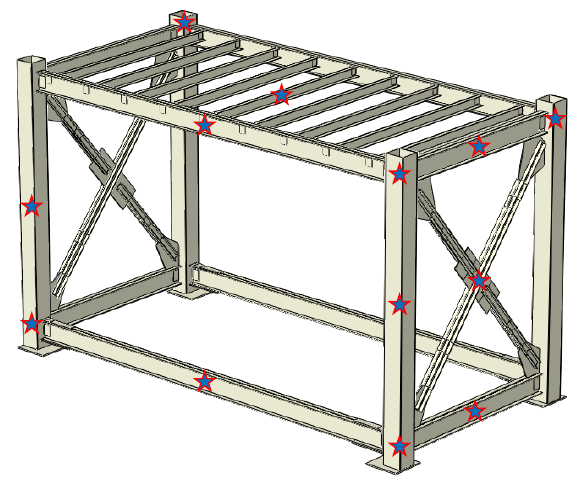
Figure 8. Locations of hammer impacts for free vibration testing of the module.